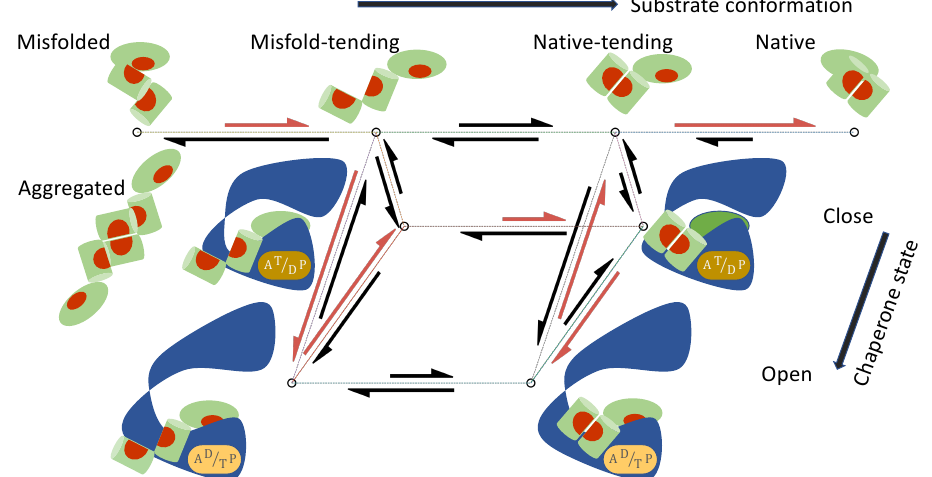
Figure 1. A mechanistic model of chaperone-mediated non-equilibrium protein folding that couples the state cycle of the chaperone and the conformational dynamics of its substrate. The chaperone undergoes a cycle of open and closed conformations, driven by ATP hydrolysis and nucleotide exchange. The protein substrate can transition among four classes of conformations: Misfolded ( M ), Misfold-tending ( U ), Native-tending ( F ), and Native ( N ) . The lengths of the reaction arrows signify the corresponding reaction rates. The red arrows indicate the predominant folding